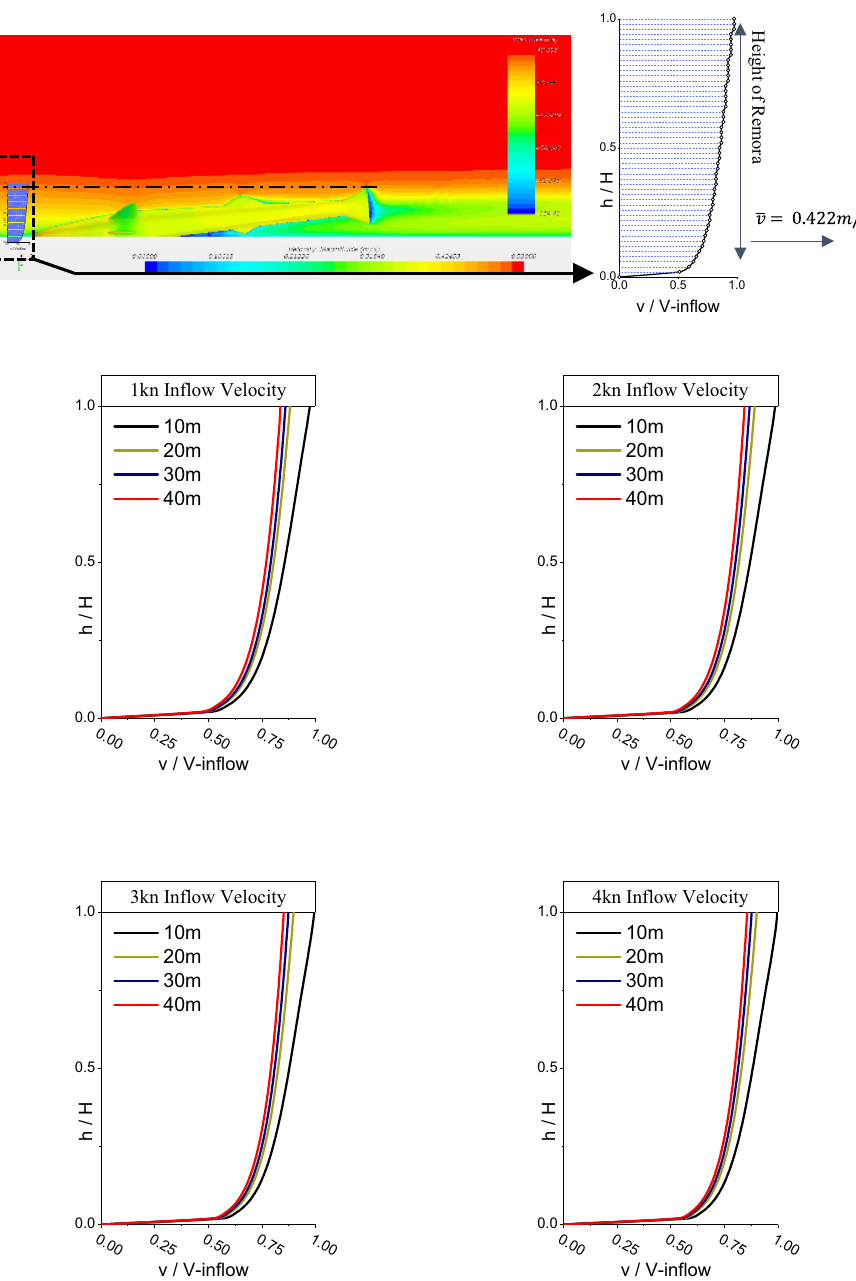
Figure 15. Summary of the velocity distributions in boundary layer at different velocities within the height of the remora